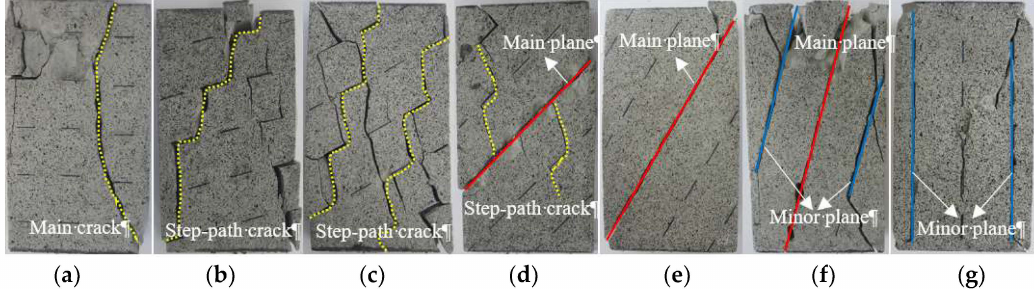
Figure 9. Failure modes of specimens with different dip angles under uniaxial compression. ( a ) α = 0 ◦ ; ( b ) α = 15 ◦ ; ( c ) α = 30 ◦ ; ( d ) α = 45 ◦ ; ( e ) α = 60 ◦ ; ( f ) α = 75 ◦ ; ( g ) α = 90 ◦ .